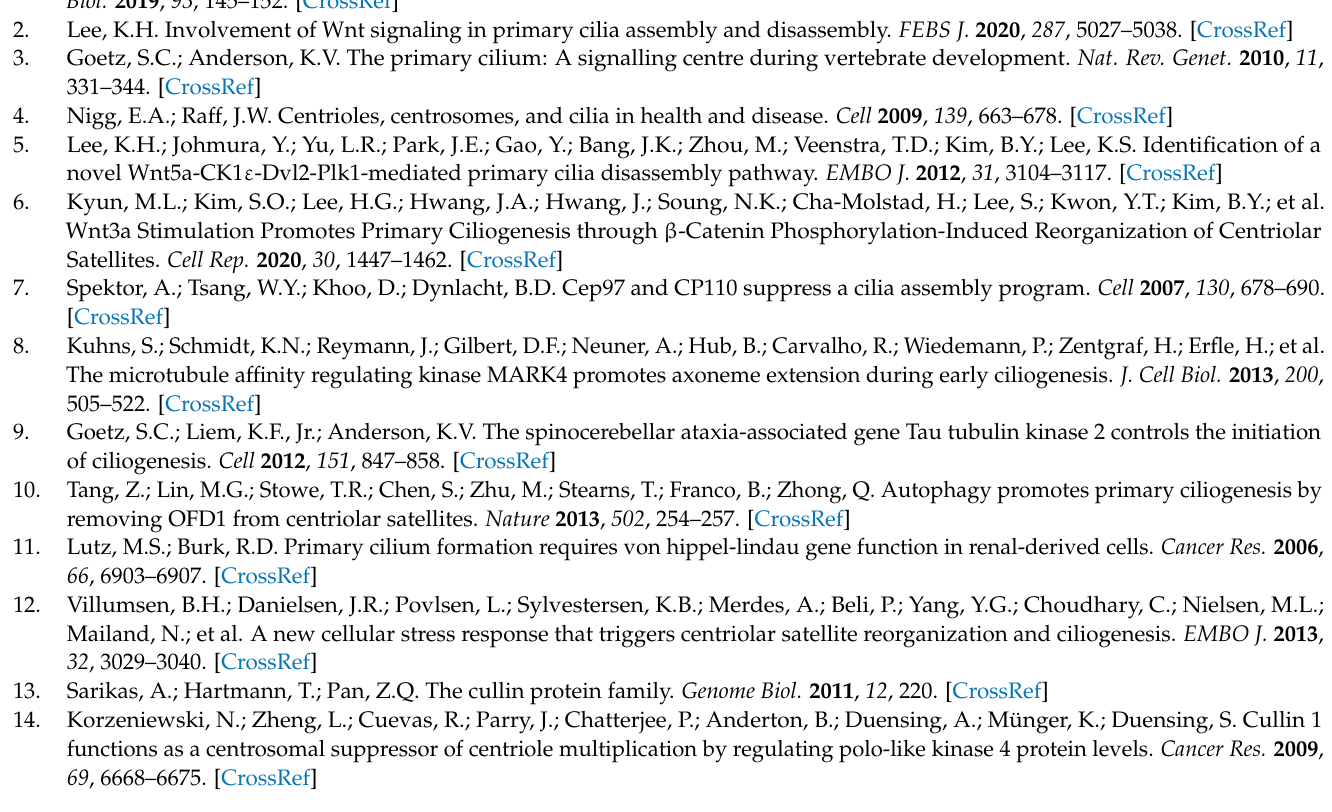
study, Supplemental Table S3: List of anti-bodies used in this study, Supplemental Table S4: List of chemicals used in this